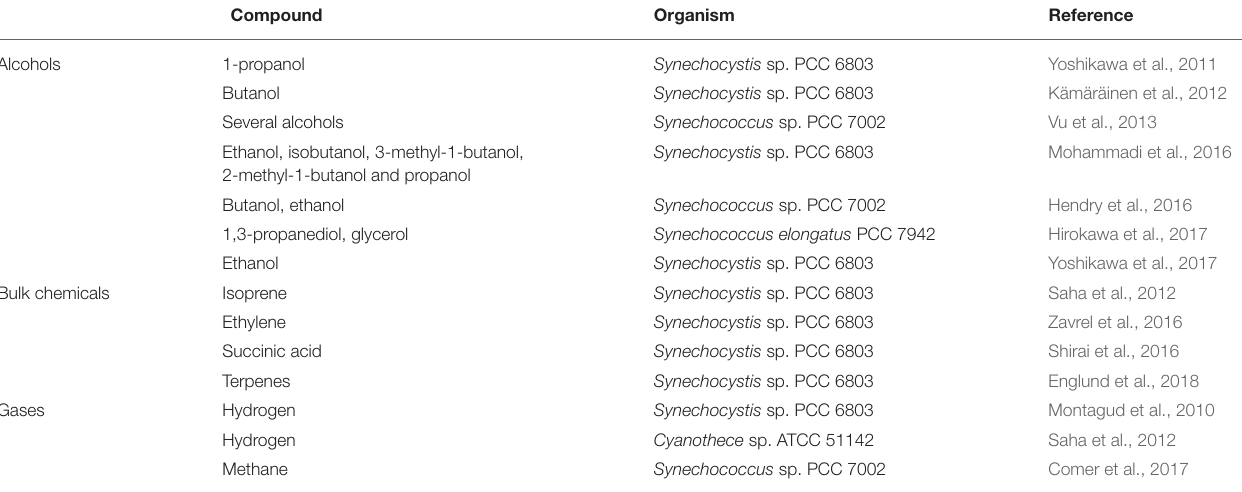
TABLE 3 | Applications of FBA to maximize the production of different compounds in